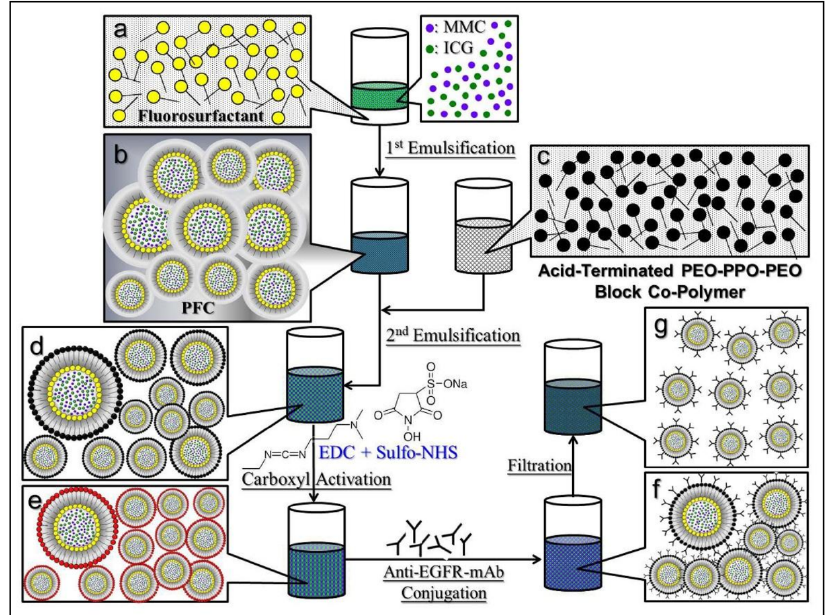
Figure 1. Schematic illustration of the manufacture protocol of the encapsulated perfluorocarbon double nanoemulsions